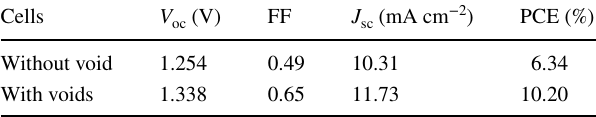
Table 1 Photovoltaic parameters of best-performing PSCs based on CsPbIBr